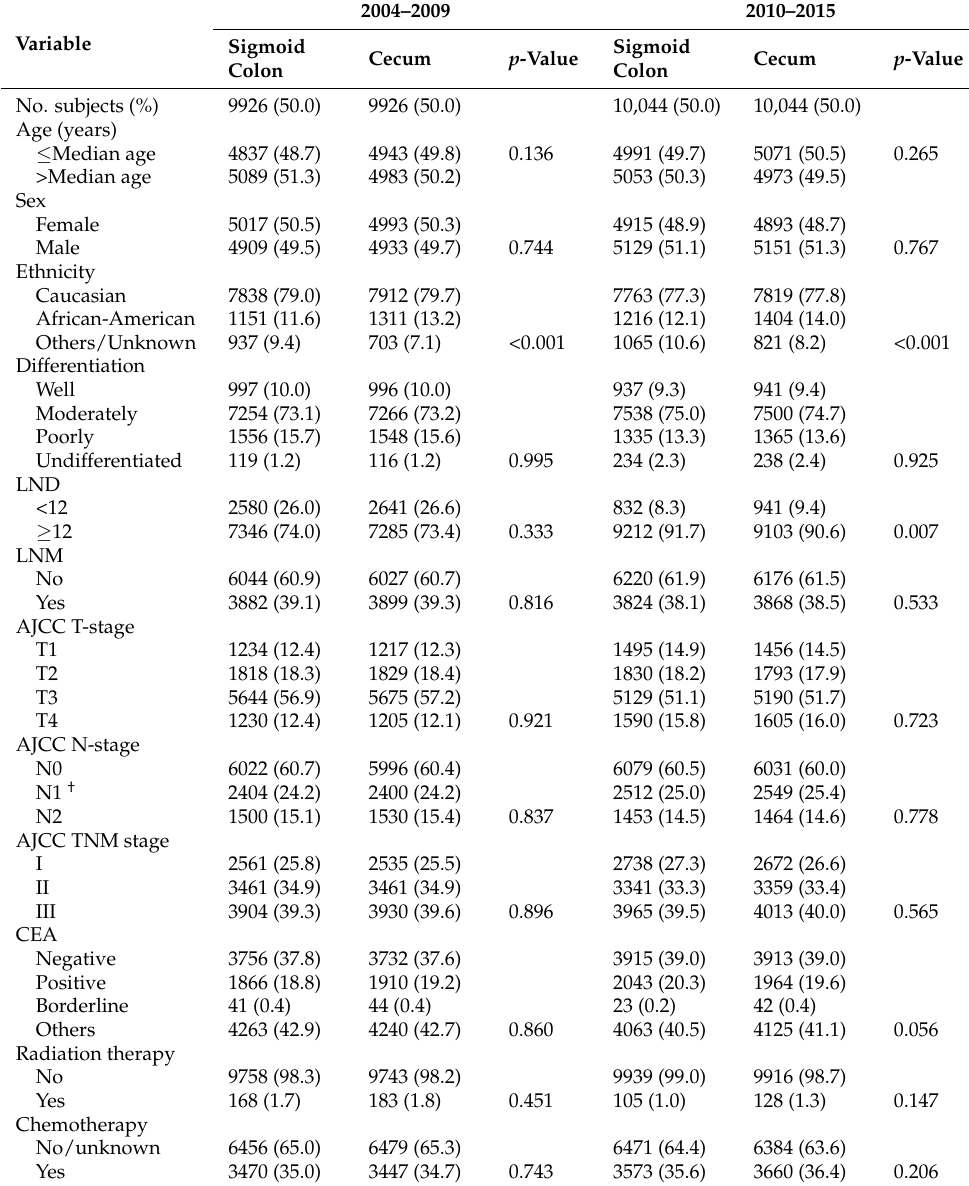
Table 3. Comparison of clinicopathological features of patients with sigmoid colon cancer versus cecum cancer after propensity score matching in the SEER